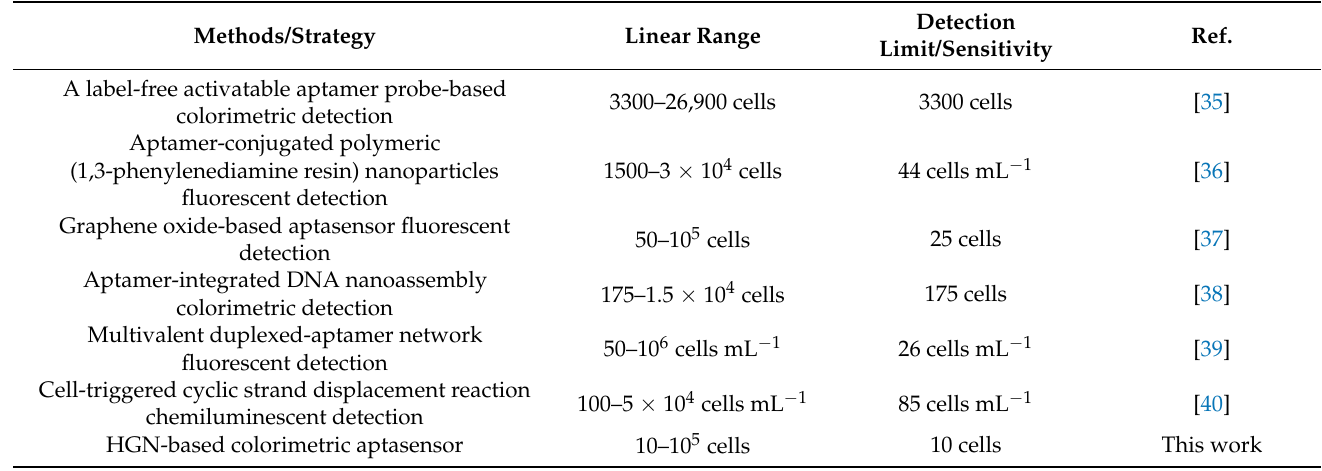
Table 1. Comparison of analytical performance of nanocomposite-based aptasensor for optical detection of CCRF-CEM